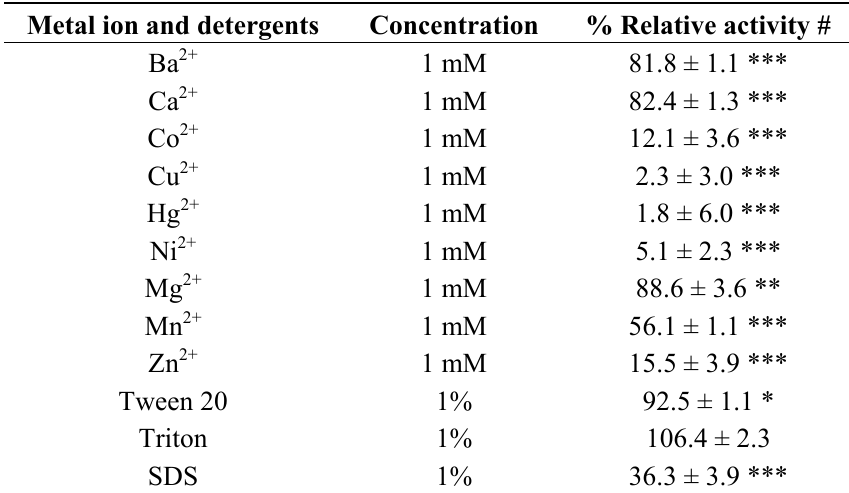
Table 1. Effects of metal ions and detergents on the azocaseinolytic activity of fraction F1.0. # Control (H O) with 100.0 ± 1.7 relative activity. * p < 0.05, ** p < 0.01 2 and *** p < 0.001 compared to control (H O). 2